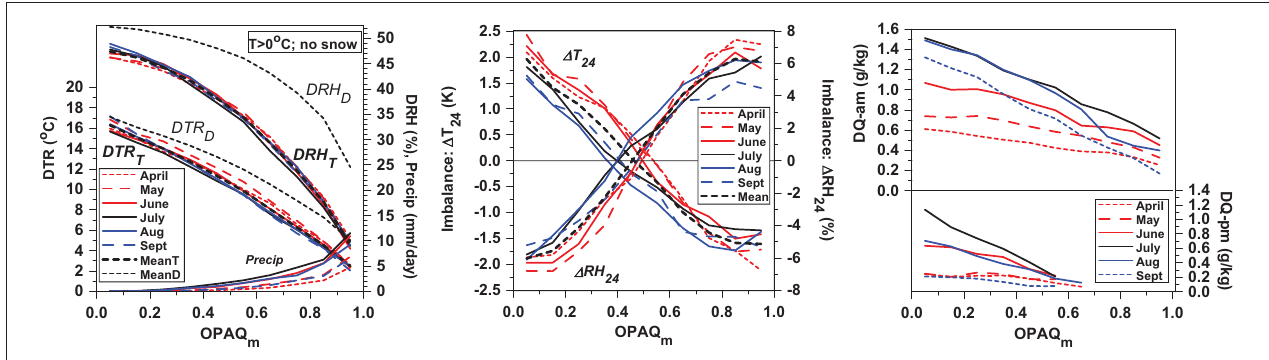
FIGURE 16 | OPAQ m dependence of DTR, DRH and precipitation (left) and (center) 24-h imbalances of 1 T 24 and 1 RH 24 , and (right) morning and afternoon rise of Q for April to September.